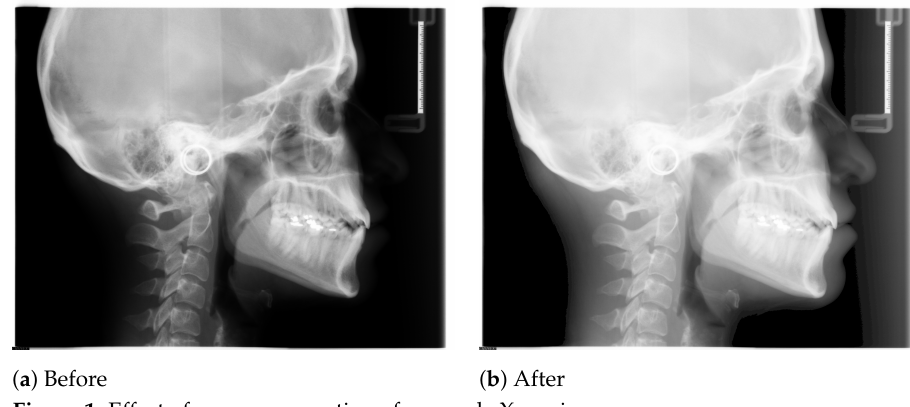
Figure 1. Effect of gamma correction of a sample X-ray image.